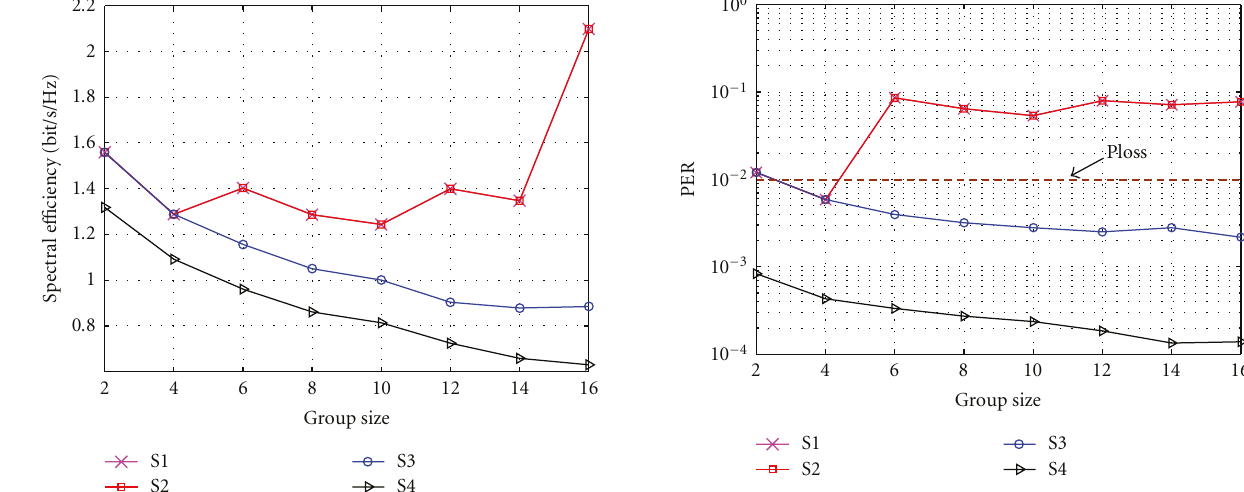
Figure 3: Spectral e ffi ciency of the first transmission.